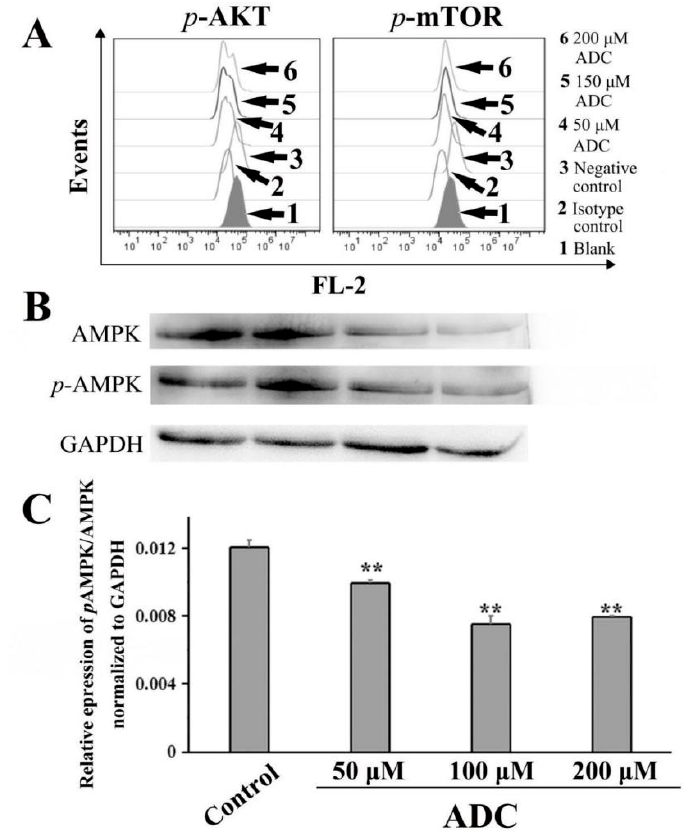
Figure 12. ADC-induced protective autophagy is attributed to the AMPK inhibition-independent blockade of the Akt/mTOR pathway. ( A ) ADC downregulated the AKT-mTOR pathway. Following treatment by ADC, cells were detected by FCAS. ( B ) ADC downregulated the AMPK pathway. Following treatment by ADC, cells underwent lysis and were detected by Western blotting. ( C ) Bar graphs demonstrate the relative expression of pAMPK/AMPK. Data are the mean ± SEM of the three independent experiments. ** p < 0.01 vs. control.